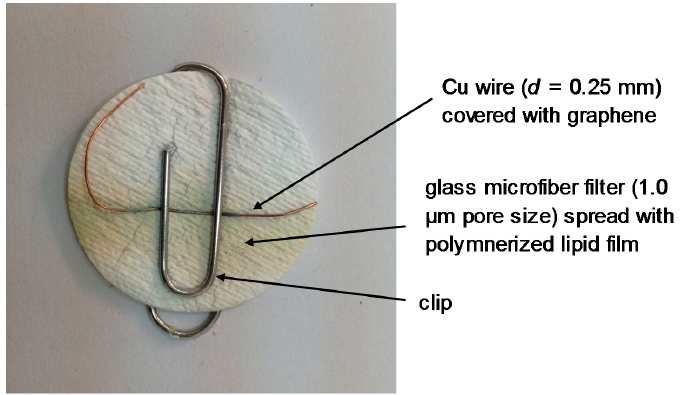
Figure 3. Photograph of the filter modified lipid-graphene microelectrode.